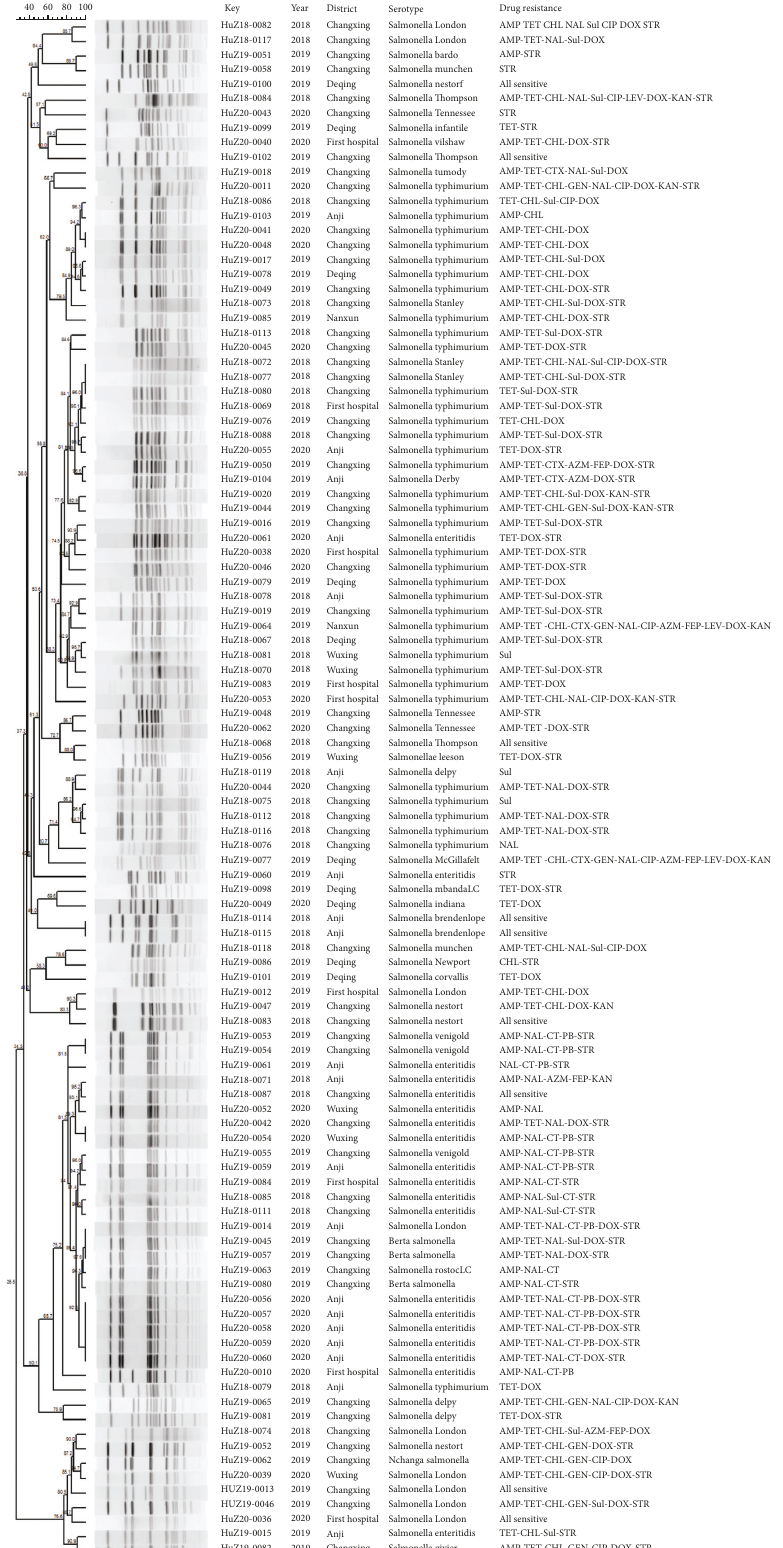
Figure 1: PFGE cluster analysis of 105 Salmonella strains collected from 2018 to 2020 in six sentinel hospitals from Huzhou, Zhejiang,